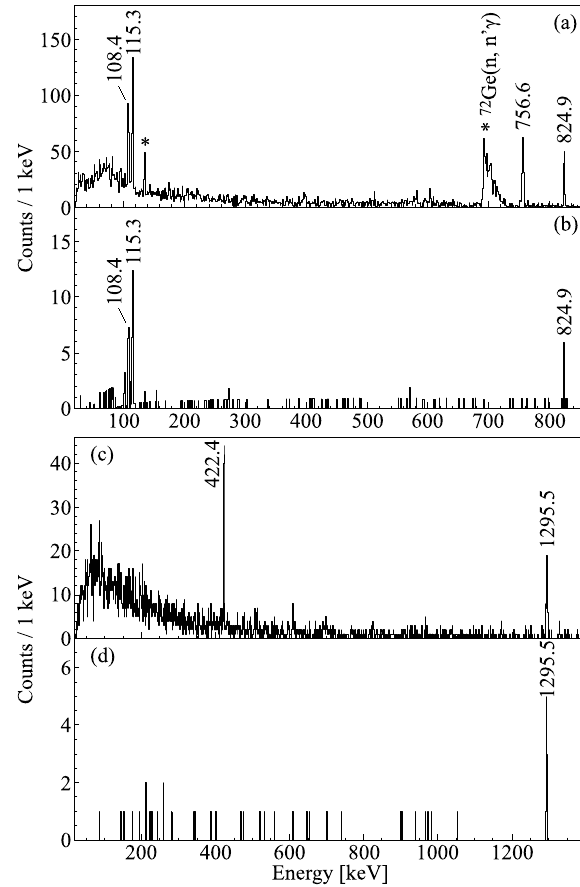
Figure 3. Gamma-ray energy spectra measured in Ref. [14]. The coincidence gate conditions are as follows. (a) and (b): Within a time range of 250 − 1250 ns after implantation of 125 Pd ions. Contaminants are marked with asterisks. An additional gate is set on the 757-keV γ ray to make the coincidence spectrum shown in the panel (b). (c) and (d): Within a time range of 0 . 25 − 100 µ s after implantation of 127 Pd ions. An additional gate is set on the 422-keV γ ray to make the coincidence spectrum shown in the panel (c).